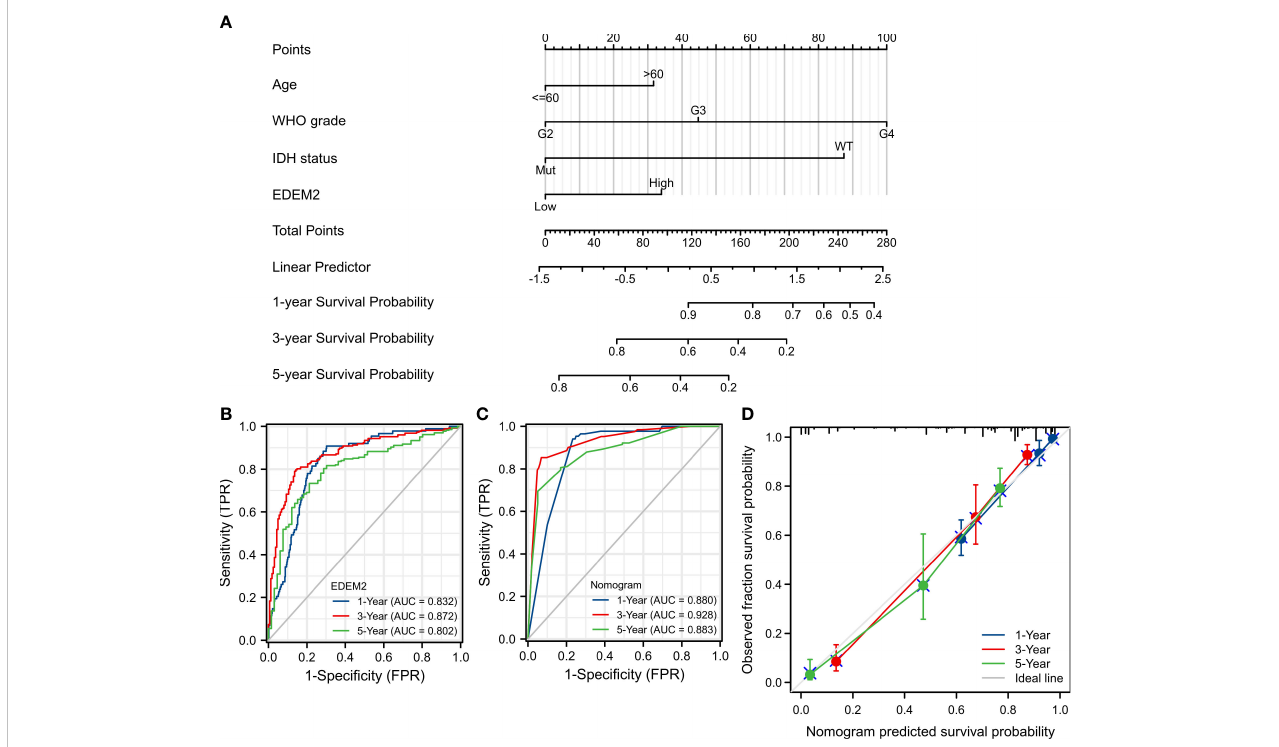
FIGURE 4 Nomogram establishment and evaluation in TCGA cohort. (A) Nomogram based on multivariate Cox analysis. (B) Time-dependent ROC curve of EDEM2. (C) Time-dependent ROC curve of the nomogram. (D) Model calibration curve